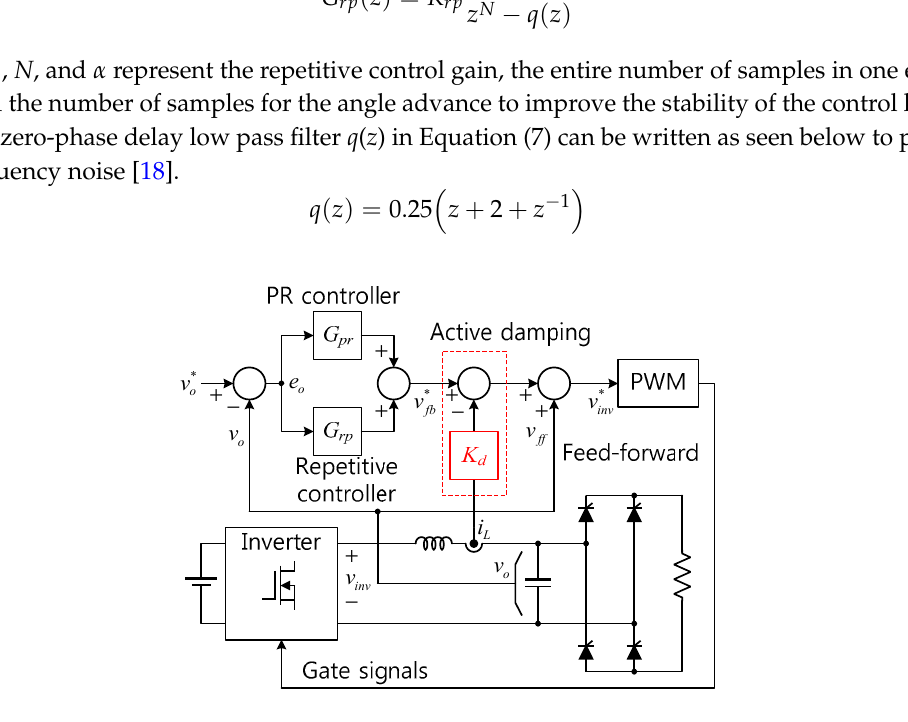
Figure 5. Proposed single-loop repetitive voltage control scheme with the active damping control.